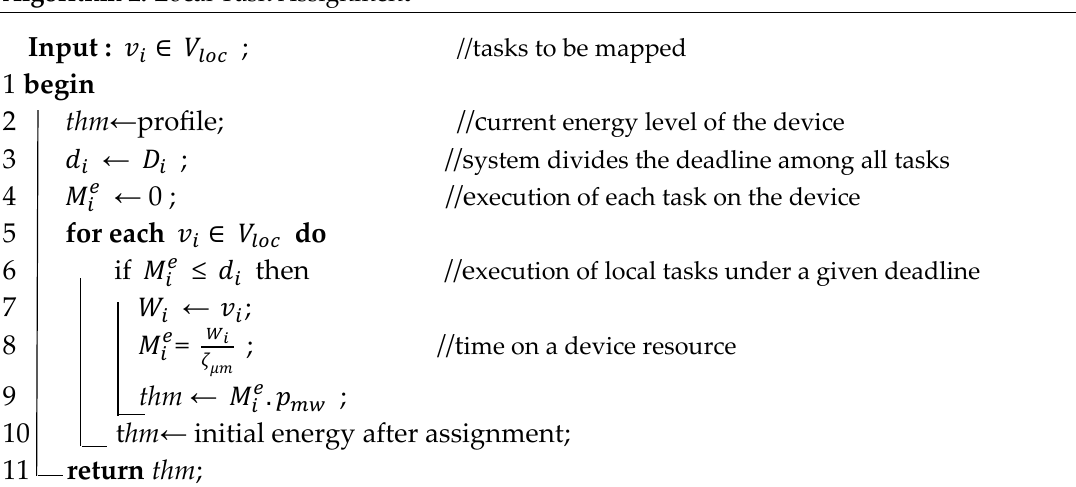
Algorithm 3: Remote Task